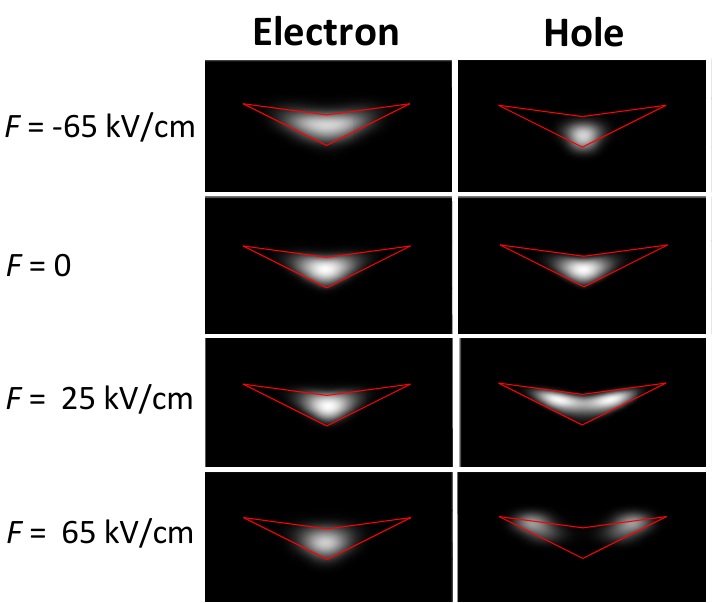
Figure 6. Grey-scale plots of cross sections through the simulated electron and hole probability densities ψ 2 e , ψ 2 inside of a CSQS (QD1, red lines) at different vertical electric fields F h